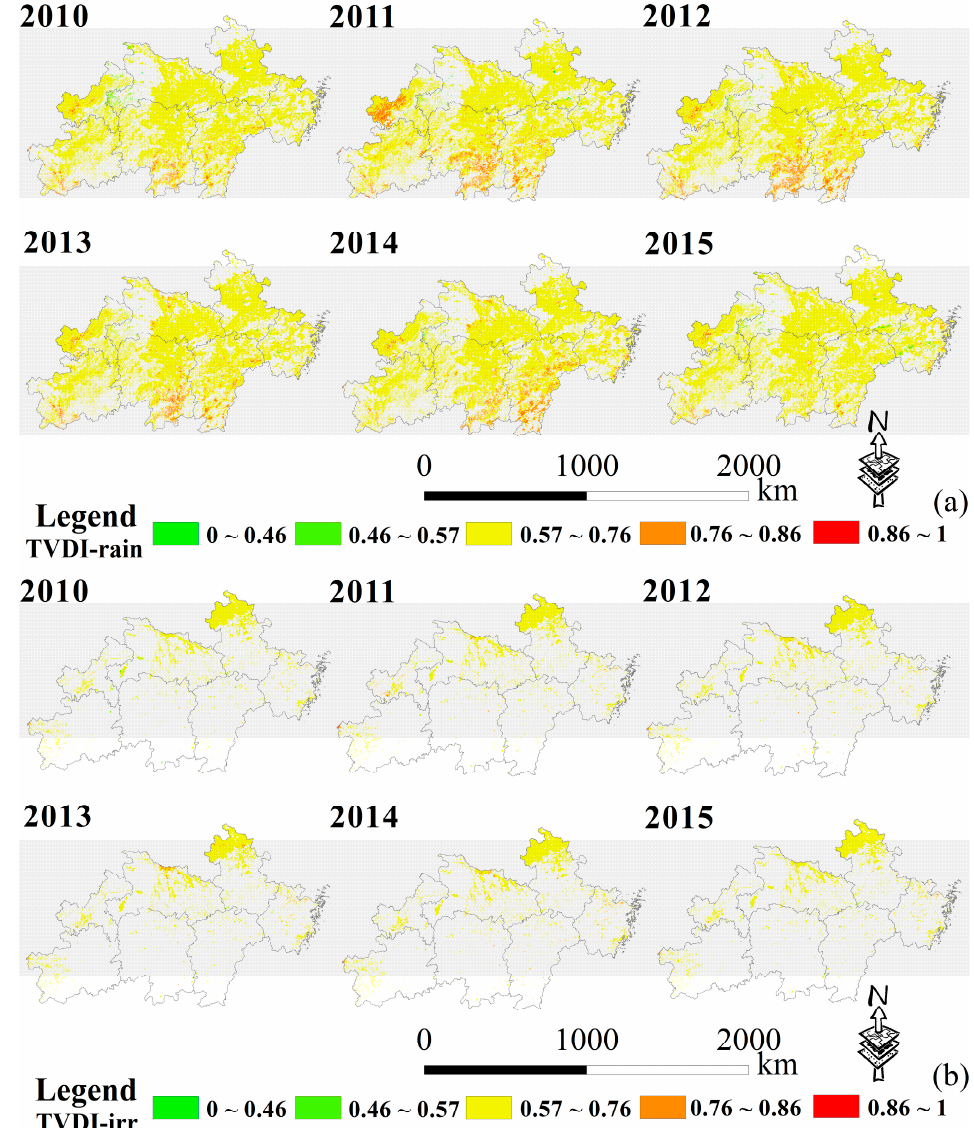
Figure 13. Spatial distribution of annual average of the TVDI in the middle and lower reaches of the Yangtze River in China from 2010 to 2015. The images without crop growth in January and December were removed. ( a ) The TVDI of rain-fed arable land (TVDI-rain). ( b ) The TVDI of irrigated arable land (TVDI-irr).